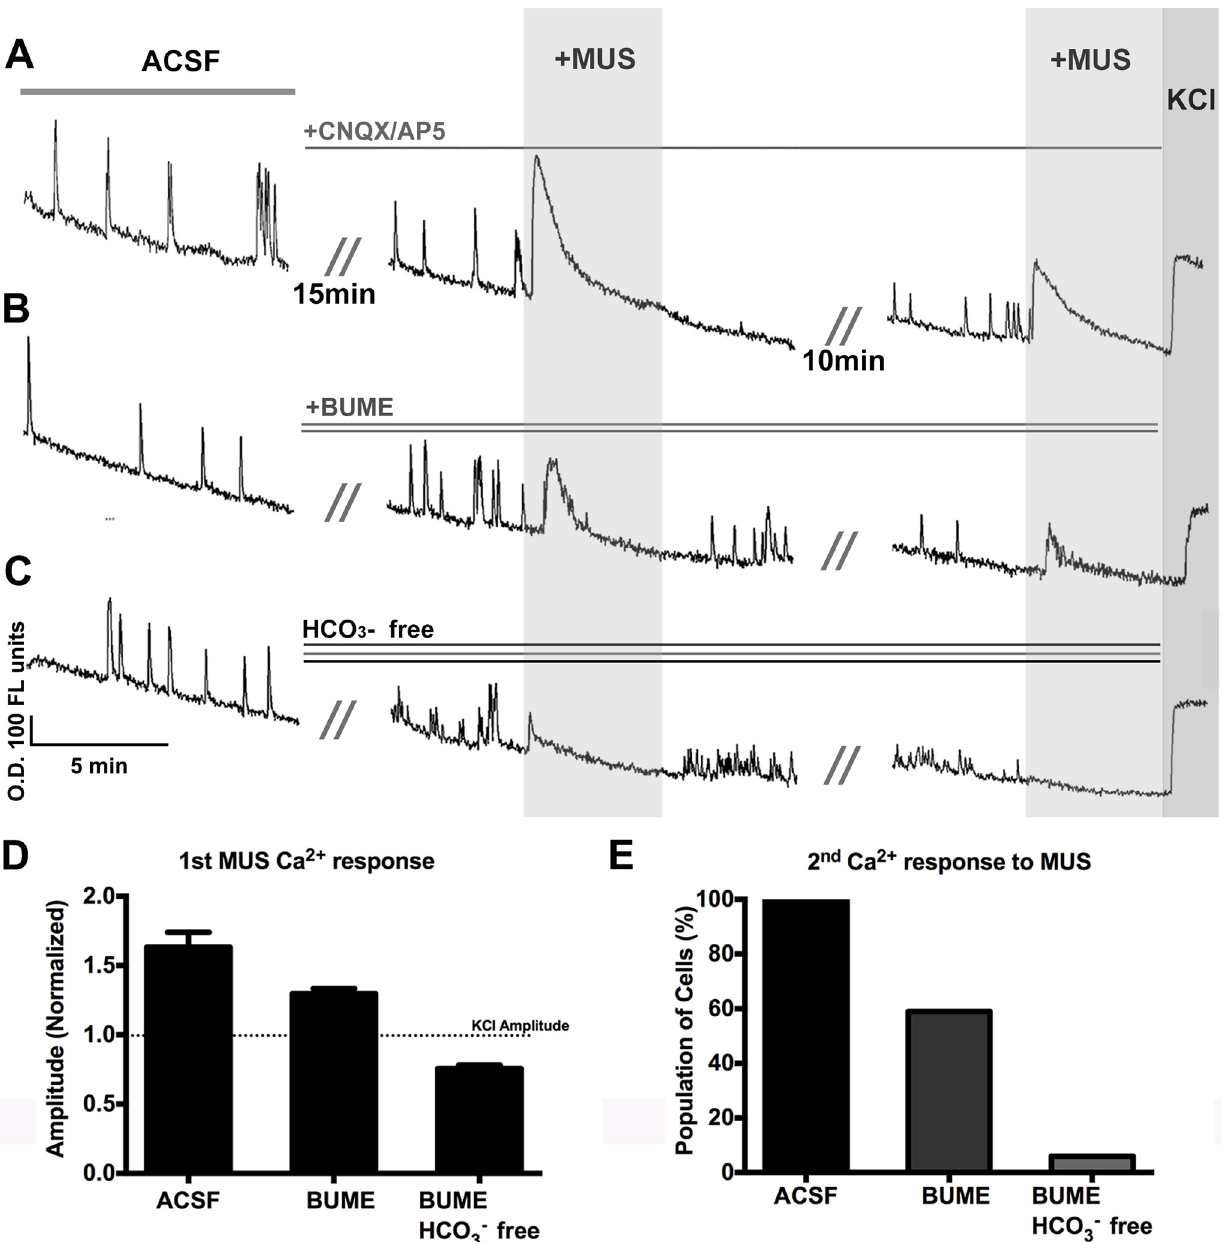
Fig 5. Inhibition of NKCC1 and removal of HCO3 - attenuates response to MUS. Recording periods consisted of: 1) baseline recording in ACSF, 2) application of CNQX/AP5 (10 μ M each) followed by MUS (10 μ M), and 3) second exposure to MUS (10 μ M), followed by KCl (20mM). Groups compared were: A) Control B) BUME (NKCC1 inhibited), and C) HCO 3 - free ACSF with BUME. Due to general fluorescent rundown in ACSF, all responses were normalized to KCl stimulus at the end, and amplitude comparisons were made. D) Amplitude of the 1st calcium responses to MUS. E) Percentage of cells retaining a calcium response to the second application of MUS. O.D. = optical